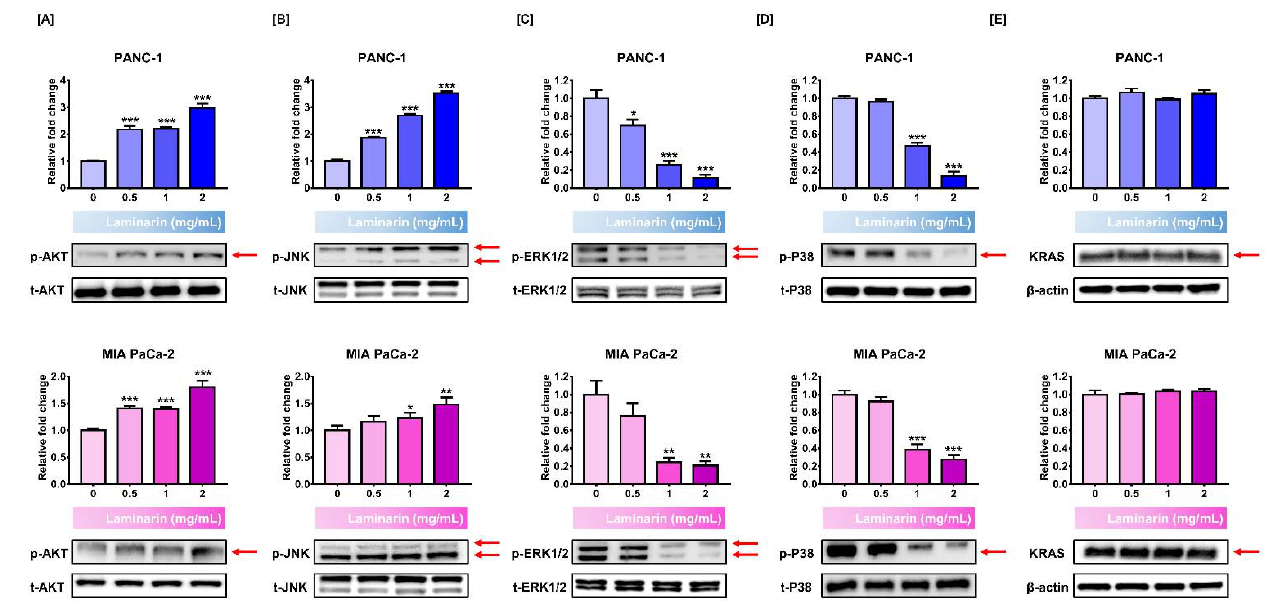
Figure 3. Effect of laminarin on signaling pathway associated with antitumor ability in PC cells. Protein levels of ( A ) p-AKT, ( B ) p-JNK, ( C ) p-ERK1/2, and ( D ) p-P38 ( E ) and KRAS expression. (* p < 0.05, ** p < 0.01, *** p < 0.001; laminin vs. control). Red arrows indicate each band of protein which is quantified. All experiments were conducted in triplicate. PC, pancreatic